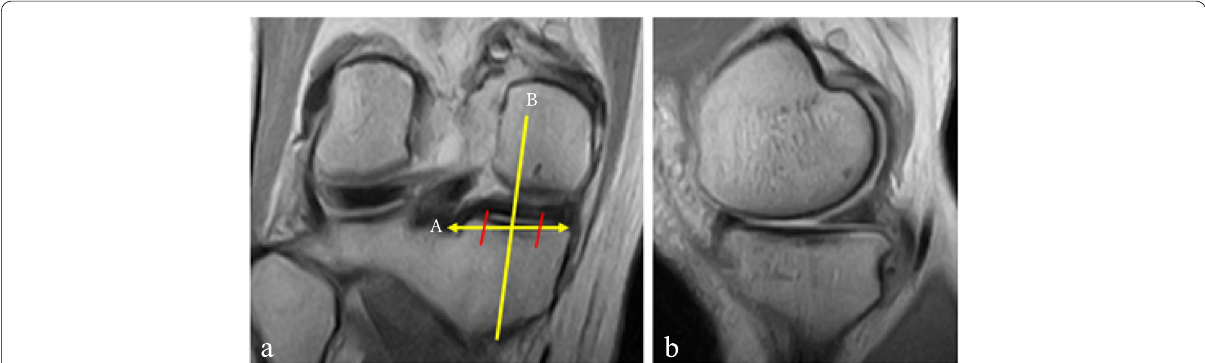
Fig. 3 Determination of the mid-posterior slice of MM posterior segment. a : Middle slice of the posterior segment in coronal image; b : Image of mid-posterior MM slice in sagittal image; A : Longest image of MM posterior segment; B : Middle slice of MM posterior segment